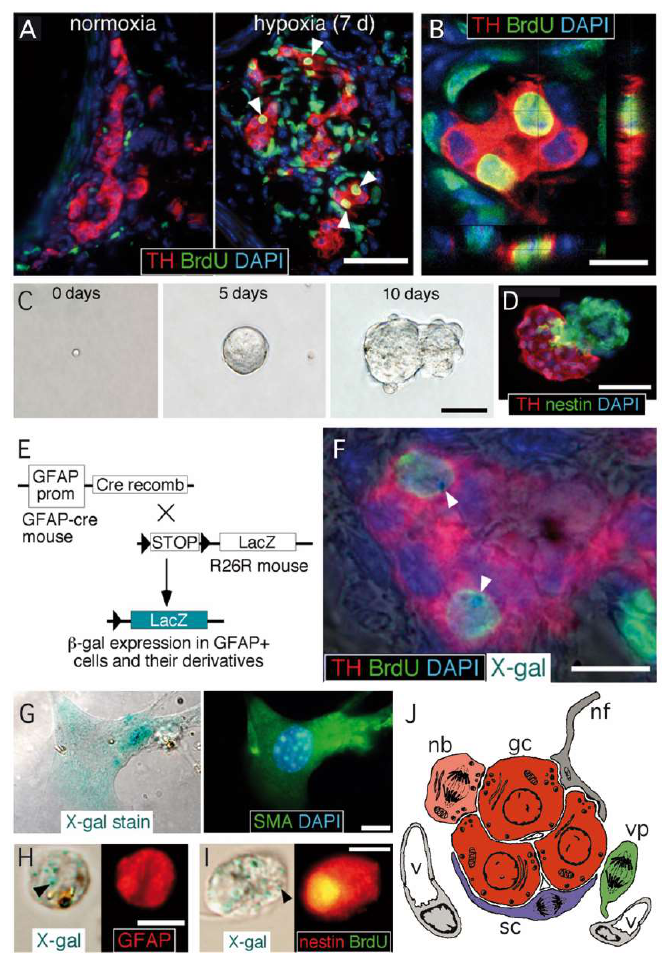
Figure 1. Carotid body germinal niche. ( A ) Immunocytochemical analysis of carotid bodies (CBs) removed from control mice (left) or from mice exposed to chronic hypoxia (10% O 2 ) (right). The panels show the typical growth of the tyrosine hydroxylase (TH)-positive glomus cell mass after 7 days of hypoxia, the incorporation of BrdU to proliferating cells, and subsequent labeling of their differentiated progeny (white arrowheads). Scale bar, 50 µm. ( B ) Confocal microscope image illustrating the colocalization of BrdU-positive nuclei surrounded of TH-positive cytoplasm. Scale bar, 10 µm. ( C ) Sequential photographs of the same colony illustrating the formation of a typical neurosphere from a single CB stem cell. Scale bar, 50 µm. ( D ) Immunohistochemical analysis of a neurosphere thin section, illustrating the presence of nestin-positive progenitors within the neurosphere core and TH-positive glomus cells within a bleb budding out the neurosphere. Scale bar, 50 µm. ( E ) Mouse model used to investigate the glial lineage of the CB progenitors giving rise to glomus cells. The carotid bodies of GFAP-cre/floxed LacZ transgenic mice were analyzed by immunohistochemistry to look for type II cell derivatives, which appear as LacZ-positive. ( F ) Merge image of an immunohistochemical detection of TH, BrdU, and DAPI, with X-gal staining indicating. The presence of blue precipitates (arrowheads), illustrates that the two newly formed BrdU-positive glomus cells within this glomerulus are derived from GFAP-positive type II cells. Scale bar, 10 µm. ( G ) Magnified images illustrating the colocalization of X-gal deposits on smooth muscle actin (SMA)-positive smooth muscle cells. Scale bar, 5 µm. ( H , I ) Examples of X-gal-positive (arrowheads) cells dispersed from the CB of GFAP-cre/floxed LacZ mice during the initial 6 days of exposure to hypoxia. Cells are X-gal-positive and GFAP-positive (in H ) or X-gal-positive, BrdU-positive, and nestin-positive (in I ). Scale bar, 10 µm. ( J ) Diagram representing the most relevant cell types present in an adult carotid body glomerulus. nb: neuroblast; gc: glomus cell; sc: sustentacular cell; vp: vascular progenitor; nf: nerve fiber; v: vessel. Panels A-I modified from [19] and panel J modified from [28] .